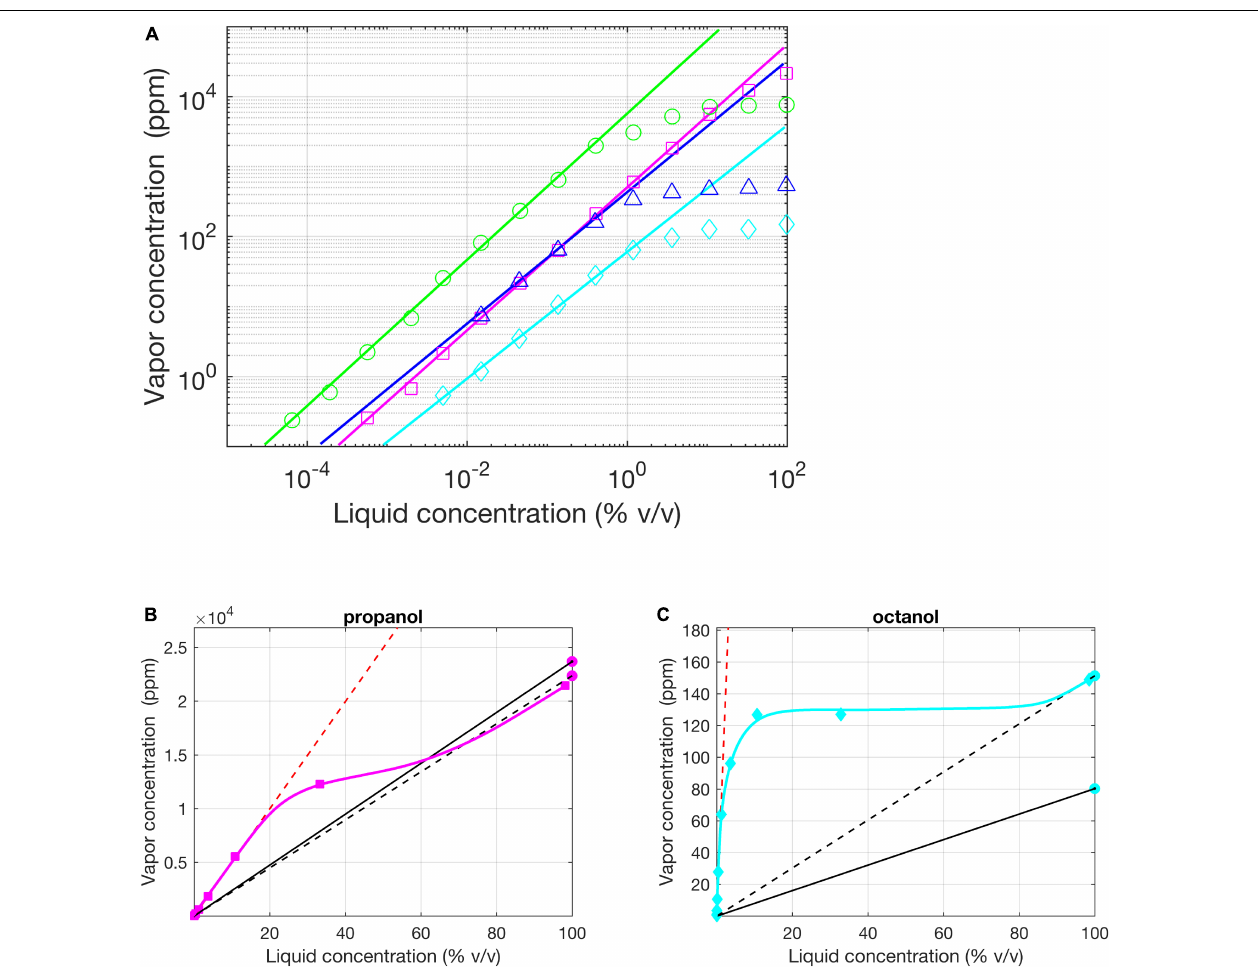
FIGURE 2 | Regimes of Henry and Raoult, experimental evidence. (A) Vapor (p.p.m. by volume) vs. liquid (% v/v) concentration for homologous alcohols in logarithmic coordinates (1-Butanol – red circles, 1-Propanol in H 2 O – green squares, 1-Hexanol – blue triangles, 1-Octanol – cyan diamonds). Except for Propanol, the solvent was mineral oil. The solid lines indicate a fit of Henry’s law to the lowest concentration values (all slope 1 in the log-log plot, indicating linear fits). (B,C) Same as (A) in a plot with linear axes for propanol in H 2 O and 1-Octanol in oil. The two black lines (dashed and solid) are the fits for Raoult’s law using the average values of vapor pressure reported by the UCSD (California) lab and UCL (London) lab, respectively. Red dashed line is the linear fit of the Henry’s Law done with the data of Cometto-Muñiz et al. (2003) (approximating β equal 1). Modified from Cometto-Muñiz et al.